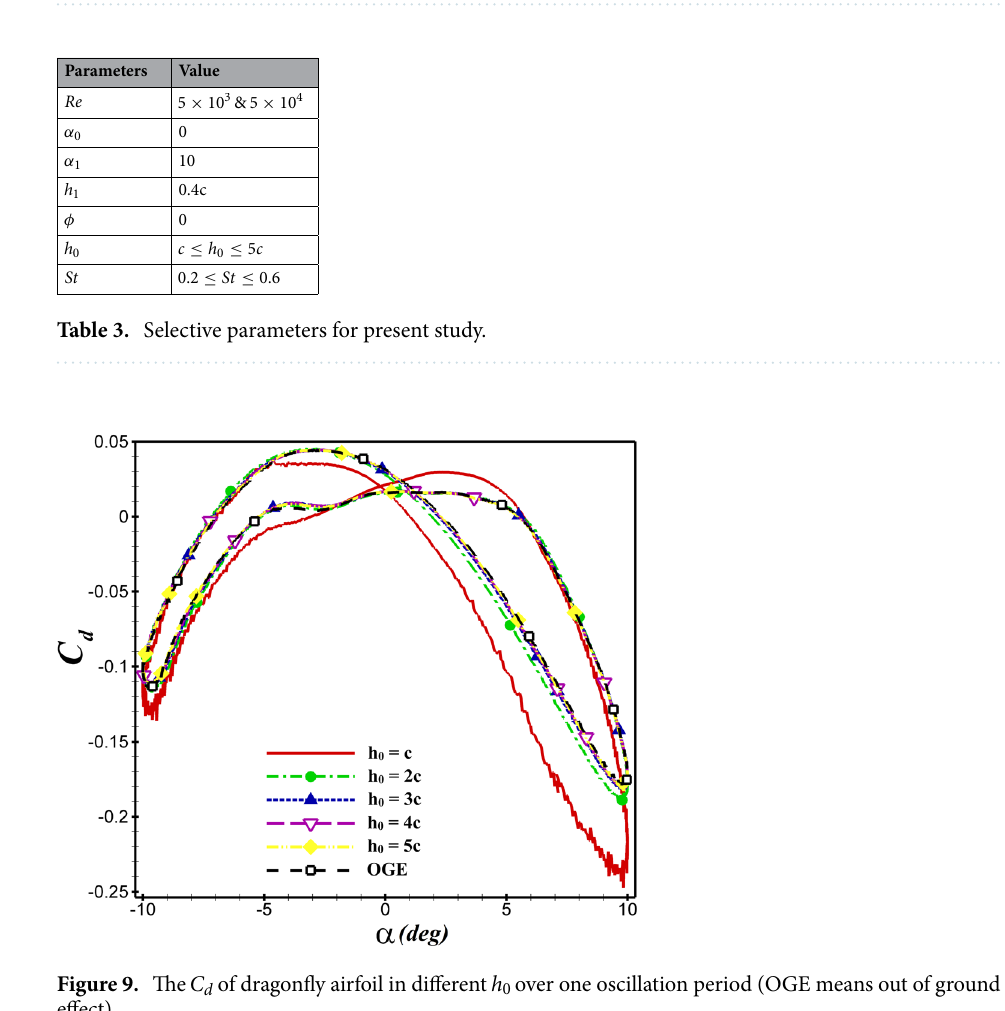
Figure 8. Flow over a flapping airfoil in ground effect.